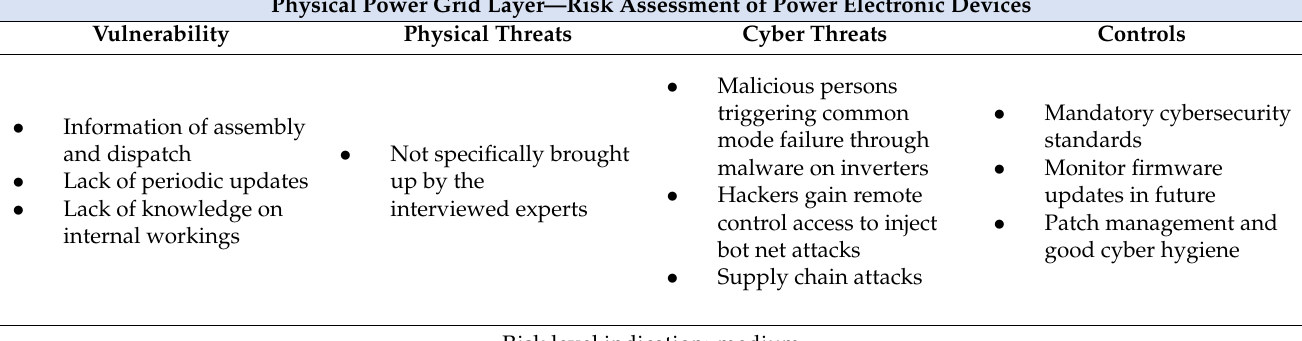
Table 6. Risk assessment of power electronic